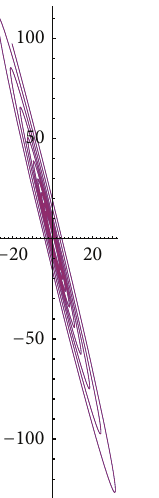
Figure 2: The equilibrium (0,0) of system (3) is unstable with 𝜏 = = 0.935 . 0.97 > 𝜏 0